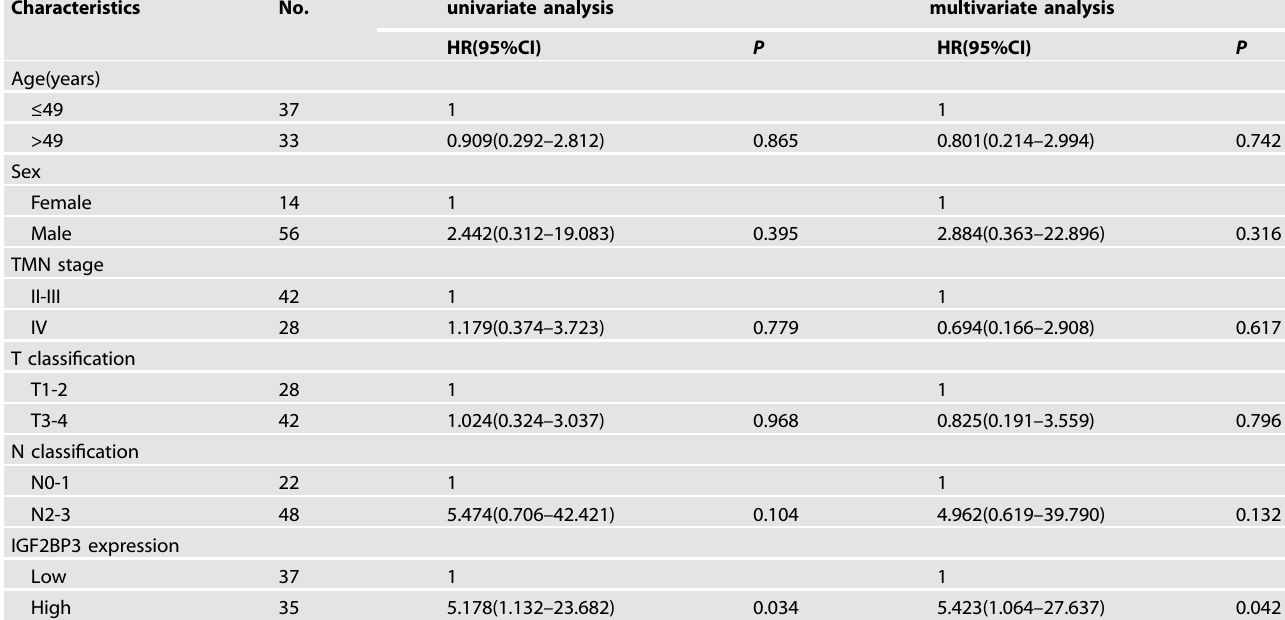
Table 2. Prognostic factors for univariate analysis and multivariate analysis.